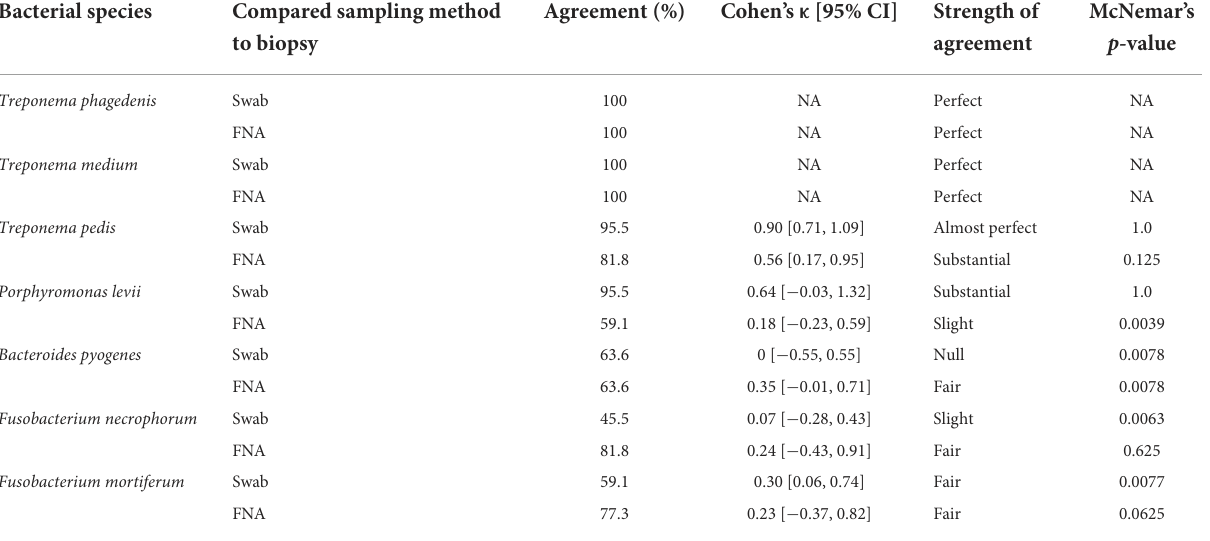
TABLE 3 Cohen’s kappa coefficient and McNemar’s p -value results of bacterial detection of the presence of each species in DD M2 lesions ( n = 22) among the sampling methods. Bacterial species Compared sampling method Agreement (%) Cohen’s κ [95% CI] Strength of McNemar’s p -value to biopsy agreement 100 NA Perfect NA